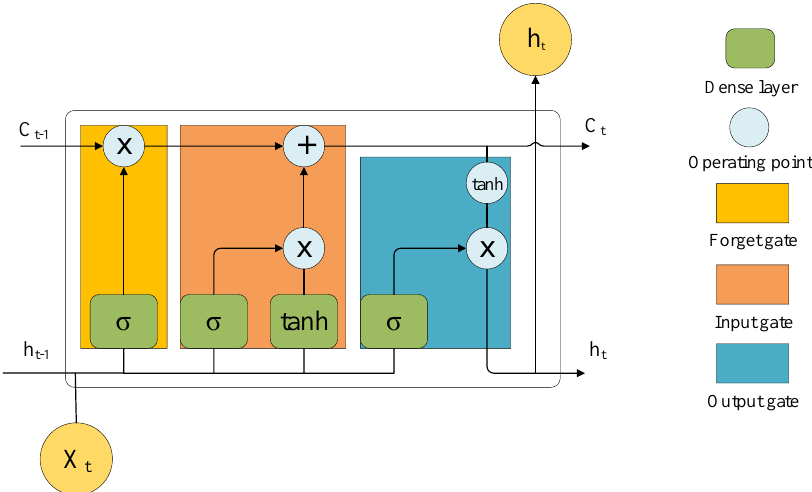
Figure 3. The structure of the LSTM